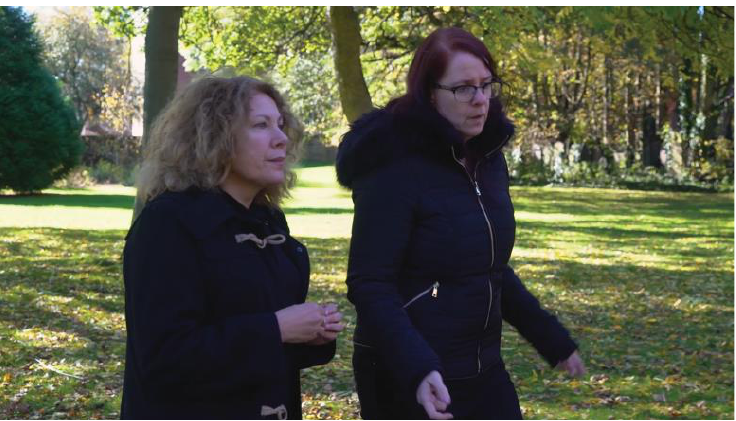
Figure 1. A still from A Conversation about Ethics , showing the discussion while walking. Directed by Sharon Hooper.